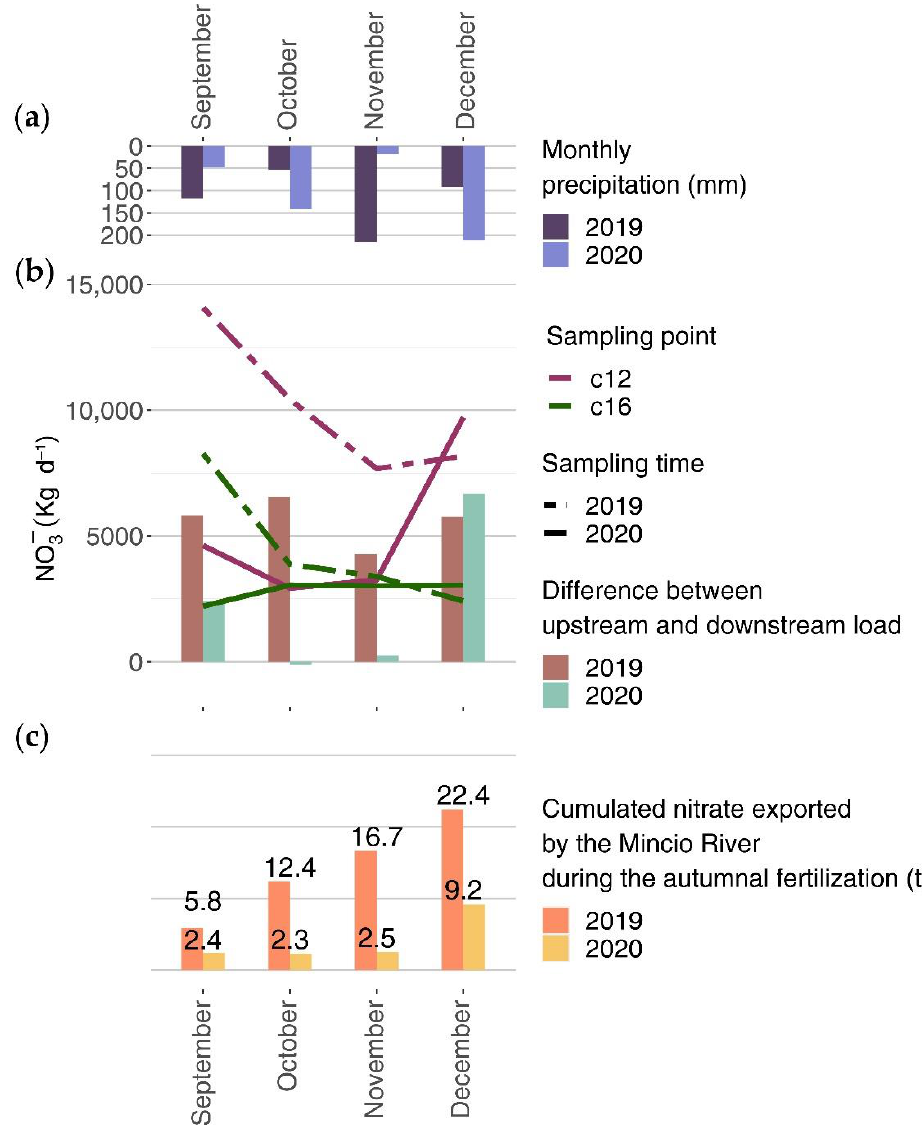
Figure 7. NO 3- loads in 2019 and 2020. ( a ) Monthly precipitation. ( b ) Loads comparison between c12 (purple) and c16 (green) in 2019 (dashed line) and 2020 (solid line). The difference in loads between them is reported in the bar plot. ( c ) Progressively cumulated loads differences between 2019 (orange) and 2020 (yellow).